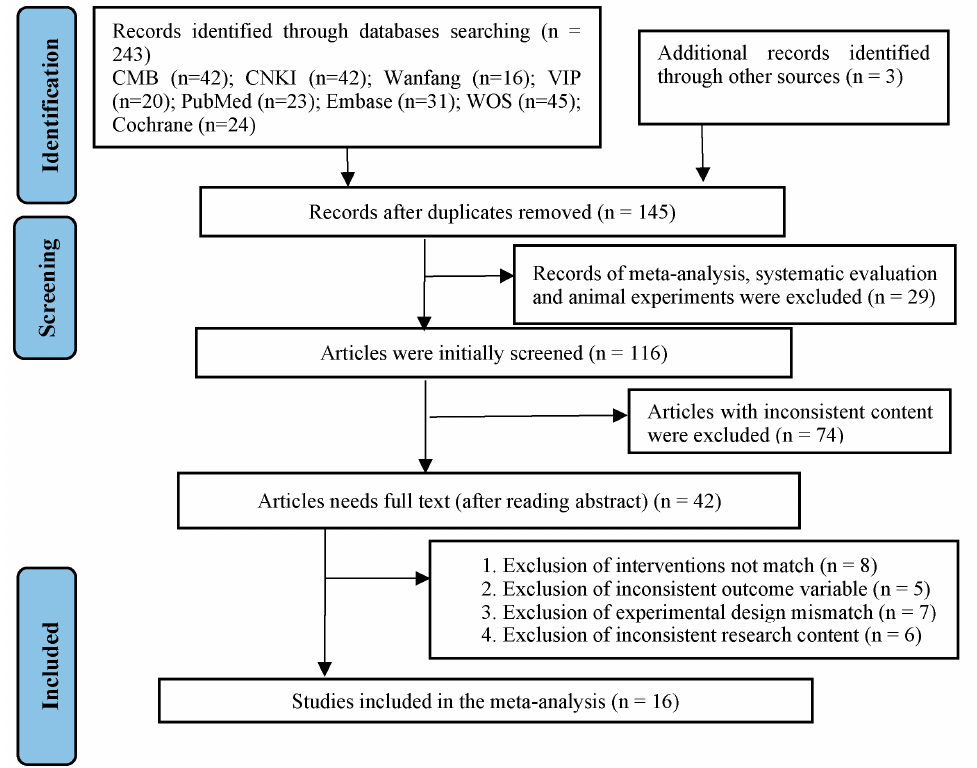
Figure 1. Flow of literature search and selection process. Table 1. Characteristics of the included studies.